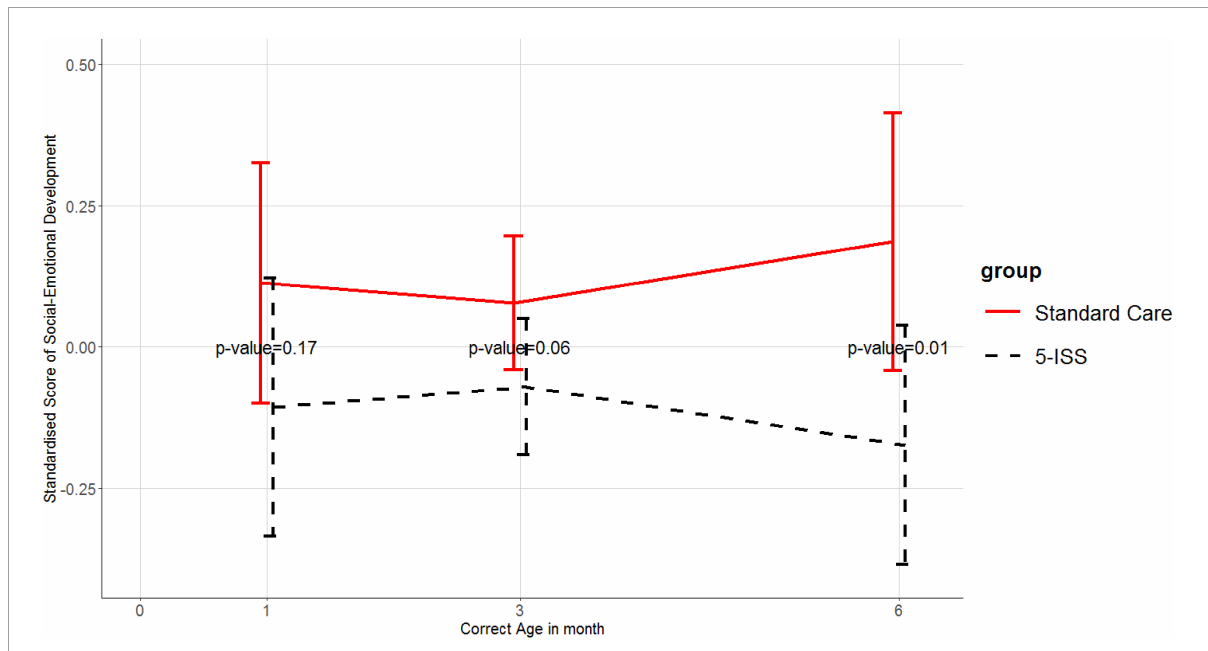
FIGURE2 Means and 95% confidence intervals of standardized scores of social-emotional development in the 5-ISS and standard care groups. Higher scores reflect a worse social-emotional